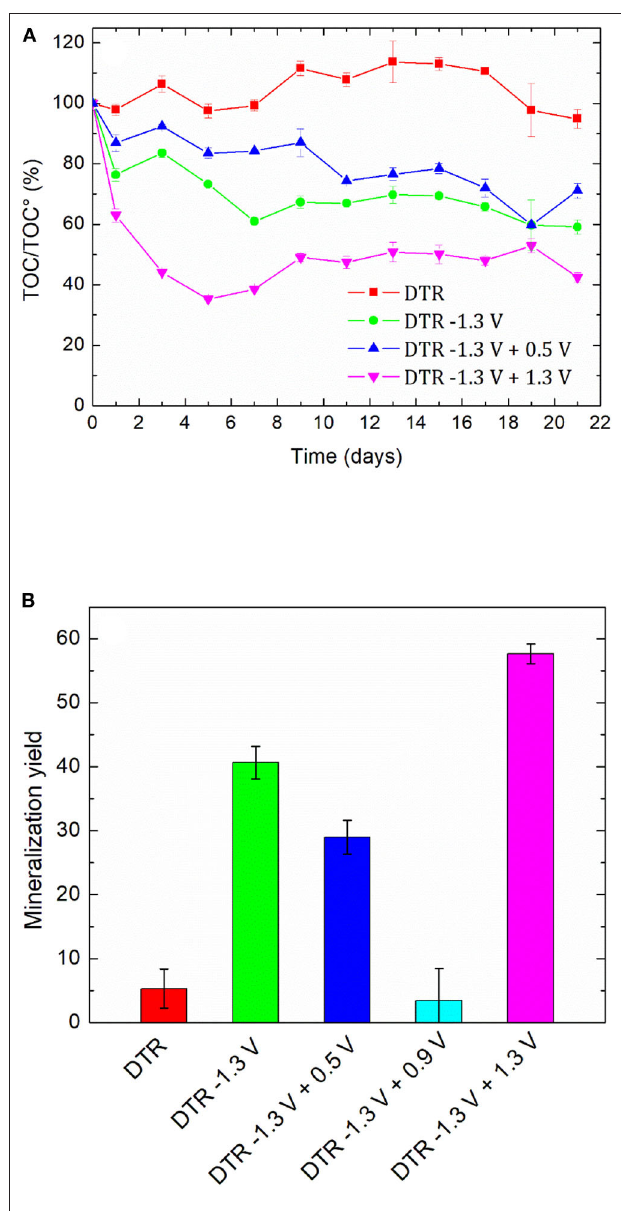
FIGURE 10 | (A) Time-courses of TOC values and (B) final mineralization yield during activated sludge culture on DTR solution (100mg L − 1 , 0.1mol L − 1 Na 2 SO 4 ) before and after electrochemical treatments. Error bars are based on triplicate